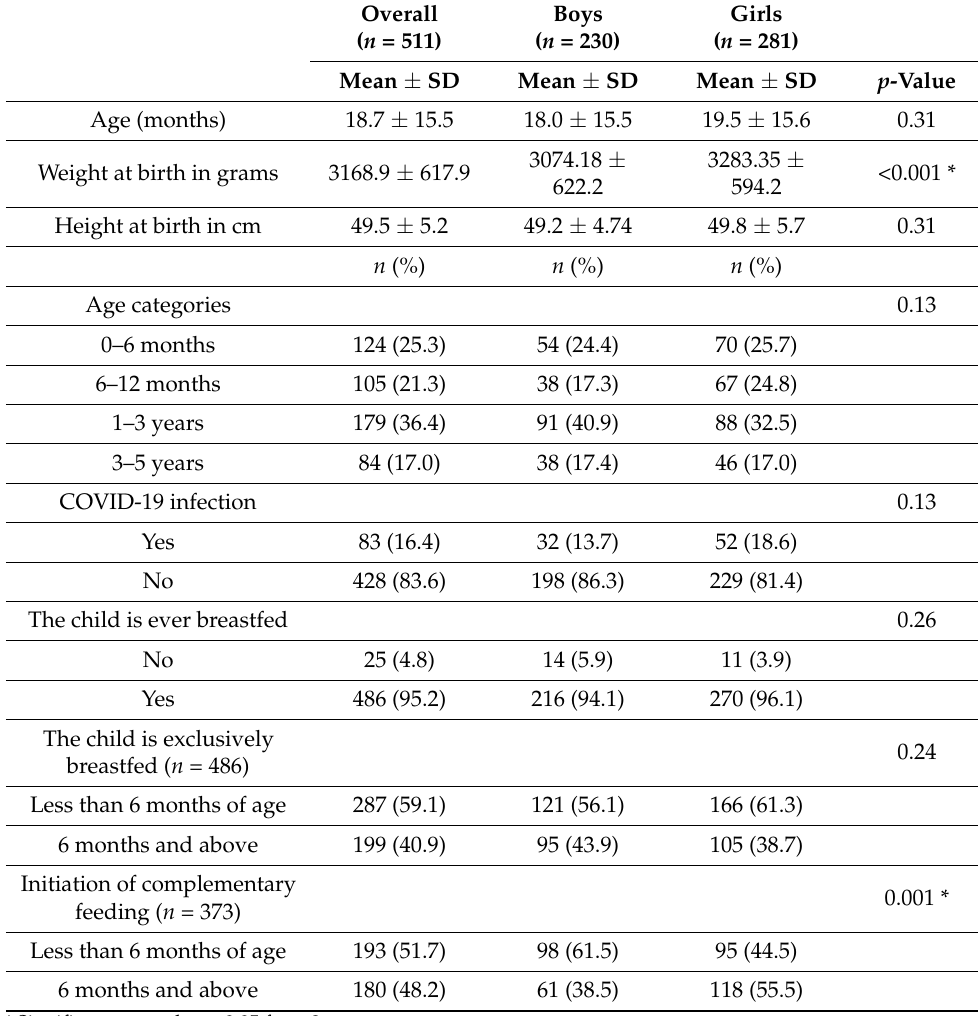
Table 2. General characteristics of under-5 children in this